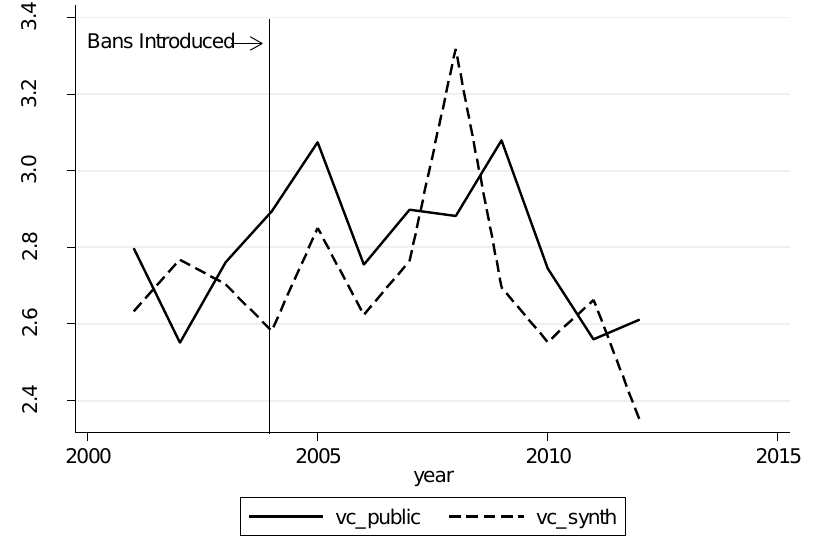
Figure A2. Trends in violent crime: public housing vs. synthetic public housing.